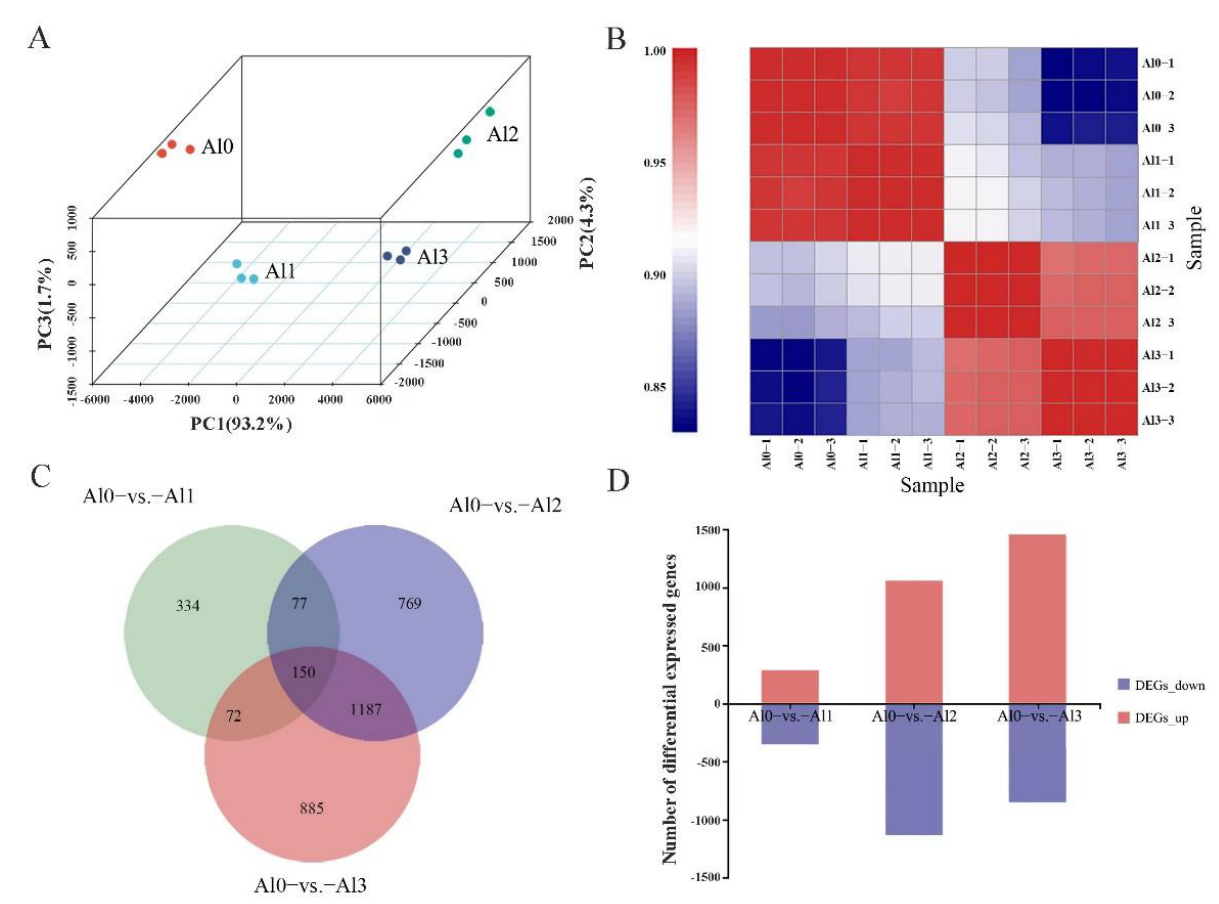
Figure 2. DEG identification and KEGG pathway analysis. Principal component analysis (PCA). The same color represents the same treatment, different colors represent different treatments ( A ). Sample-to-sample clustering analysis. The red color depicts the up-regulation, and blue color depicts the down-regulation in the gene expression pattern ( B ). Venn diagram showing overlapping and unique DEGs between different peanut samples Al0 vs. Al1, Al0 vs. Al2, and Al0 vs. Al3 ( C ). Statistical chart of DEGs under different concentrations of Al 3+ . Red indicates up-regulation, and blue indicates down-regulation ( D ).